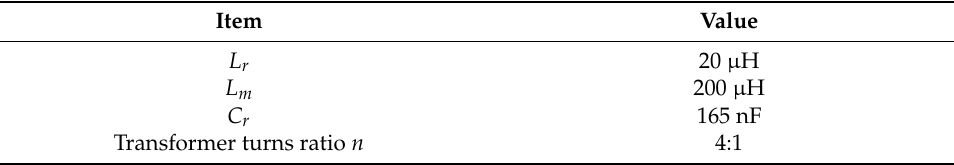
Table 5. Parameters of resonant tank.